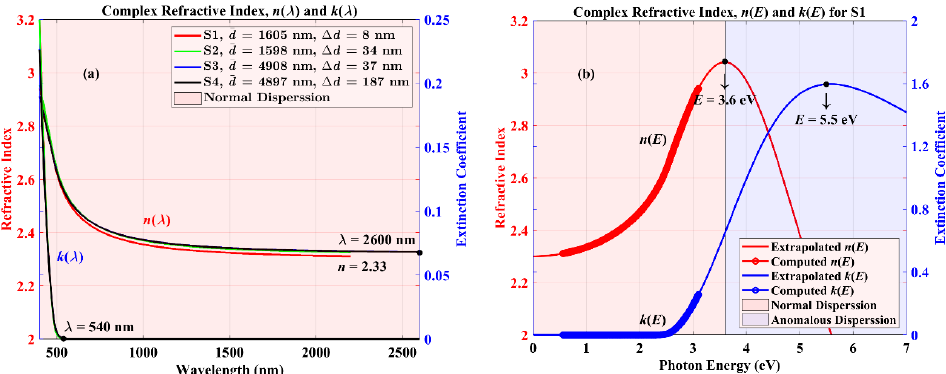
Figure 8. ( a ) The complex refractive indices obtained from the four transmission spectra analyzed. ( b ) Extrapolated optical constants ( n ( E ), k ( E )) of a representative chalcogenide specimen, following the Tauc–Lorentz–Urbach oscillator function (plotted for the spectral range 0.2–7 eV, or equivalently, 200–6200 nm). The regions of normal and anomalous optical dispersion are colored differently.